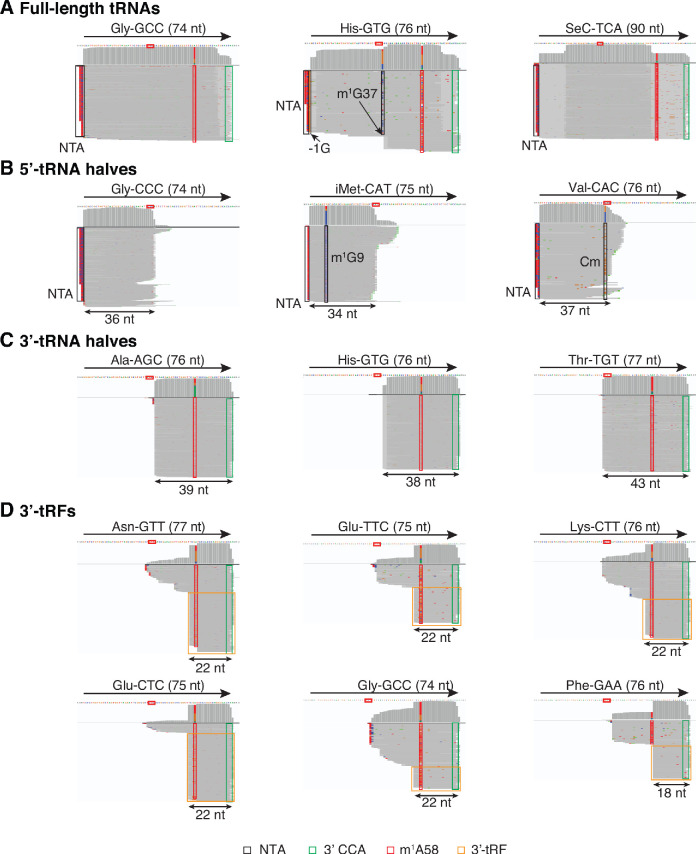
IGV screenshots showing examples of full-length mature tRNAs and tRNA fragments detected in plasma by TGIRT-seq.(A) Full-length mature tRNAs; (B) 5'-tRNA halves; (C) 3'-tRNA halves; and (D) 3'-tRFs. The tRNA name and length are indicated at the top, with an arrow indicating the 5' to 3' orientation, and the tRNA sequence with anticodon positions boxed in red shown below. The IGV coverage plots and alignments below the tRNA sequence were generated from combined datasets for DNase I-treated plasma RNA (n = 12) mapped to mature tRNA reference sequences containing a 3' CCA tail (Chan and Lowe, 2016). Coverage at each position along the gene is shown in the top track, and read alignments are shown below with reads down sampled to a maximum of 100 reads for display when necessary. Gray represents bases that match the reference base. Other colors indicate bases that do not match the reference base (red, green, blue, and brown indicate thymidine, adenosine, cytidine, and guanosine, respectively). Misincorporation at known sites of post-transcriptionally modified bases are highlighted in the alignments: red boxes, m1A58: 1-methyladenosine at position 58; black boxes, m1G37 in His-GTG, m1G9 in iMet-CAT, Cm (2’O-methylation of ribose at C34) in Val-CAC, and −1G in His-GTG. Because tRNA halves and tRFs are much less abundant than mature tRNAs, for visualization in panels B-D, only read pairs with read span < 50 nt and a 3'-RNA end mapping to the anticodon loop are shown for 5’-tRNA halves, and only read pairs with a read span < 50 nt and ending with a 3'-CCA tail are shown for 3'-tRNA halves and 3'-tRFs. Reads corresponding to 3’-tRFs are in orange boxes, and 3’ CCAs are in green boxes. NTA/black boxes are non-templated nucleotides added by TGIRT-III to the 3' end of cDNAs (5' end of the RNA sequence) during TGIRT-seq library preparation.